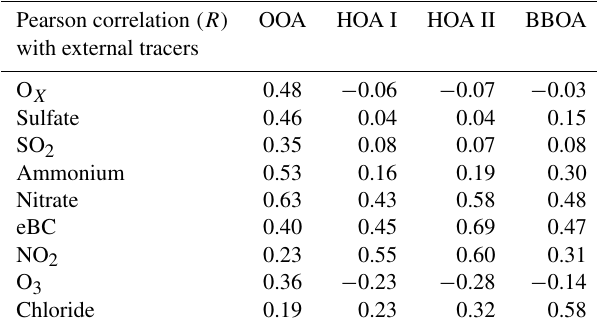
Table 4. Pearson correlation coefficients (R) between time series of OA factors and time series of aerosol components and trace gases. Aerosol components include sulfate, nitrate, ammonium, chloride, and equivalent black carbon time series. Trace gases include sulfur dioxide, nitrogen dioxide, ozone, and oxidant concentration (O x = O 3 + NO 2 ) time